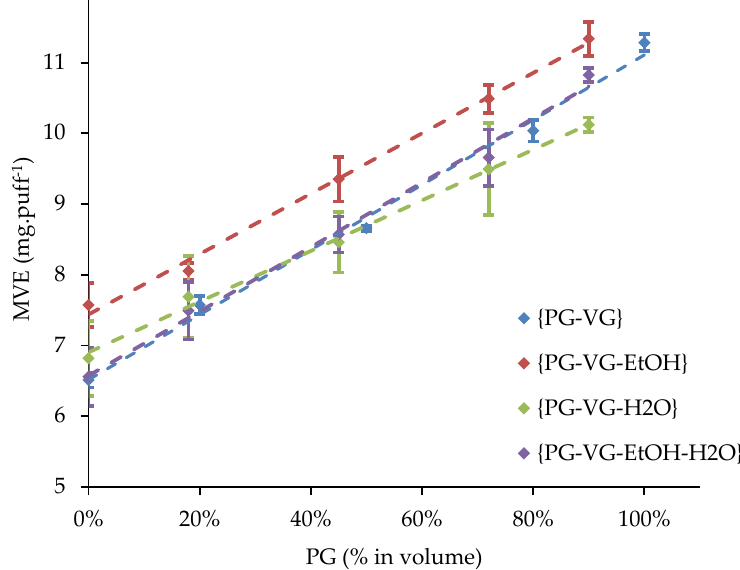
Figure 5. Influence of the PG volume fraction of {PG-VG}, {PG-VG-EtOH}, {PG-VG-H 2 O}, and {PG-VG-EtOH-H 2 O} mixtures on their MVE (measured at ambient temperature, with a supplied power of 15 W).